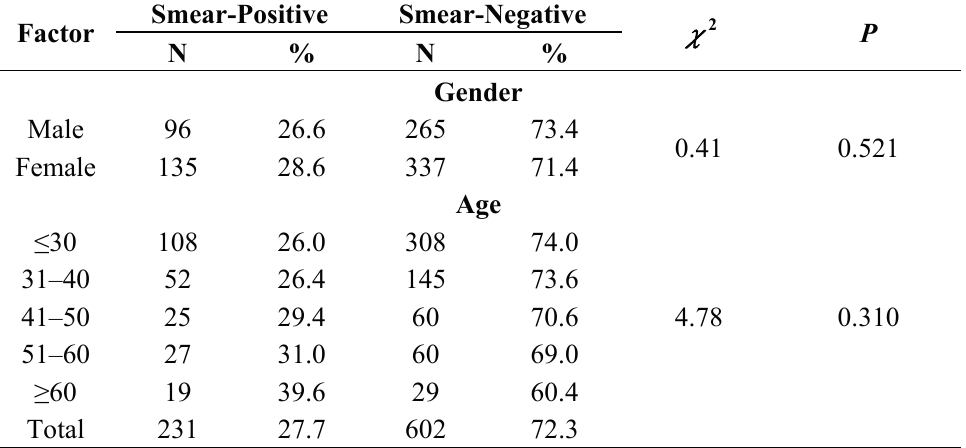
Table 3. Results sputum smear among Healthcare Worker (HCW) with Tuberculosis (TB).